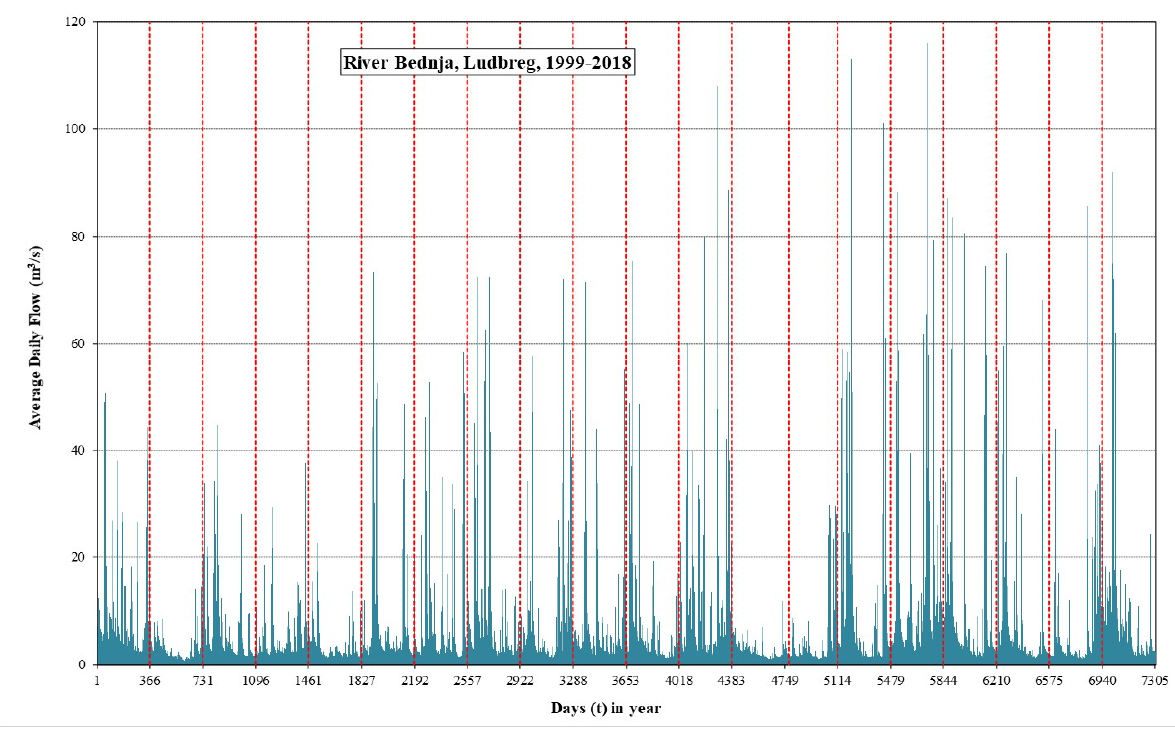
Figure 2. Average daily flow of the river Bednja, 2020.